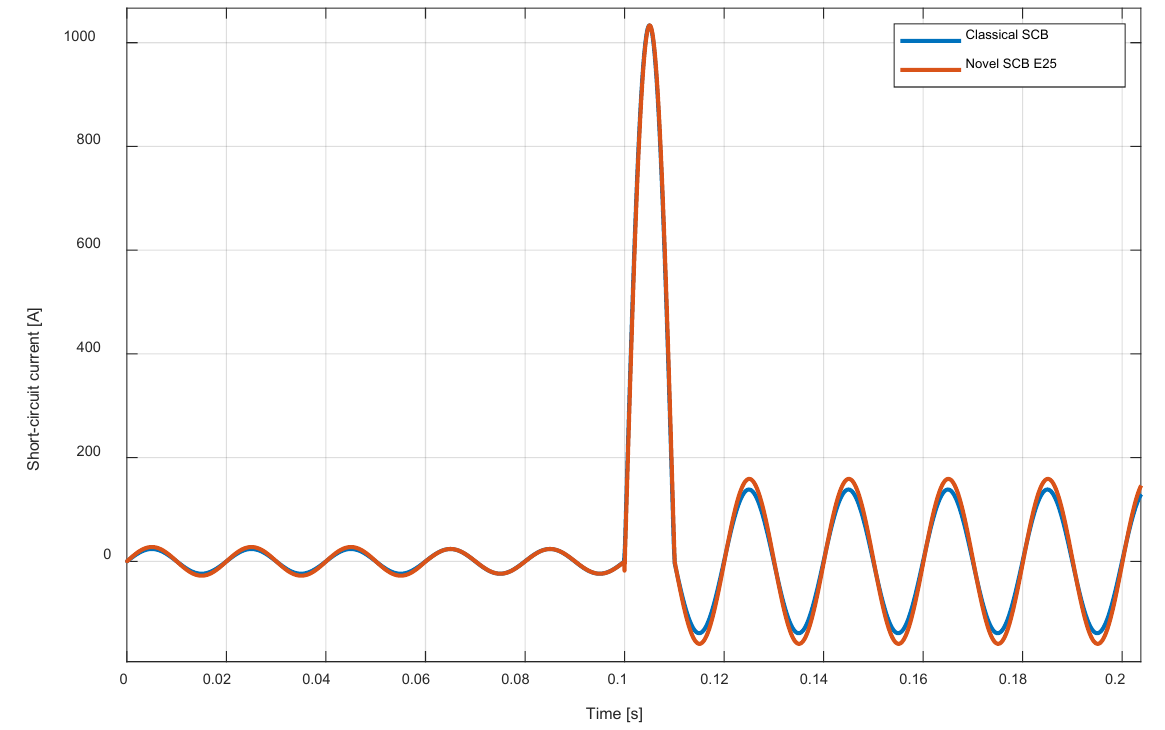
Figure 8. The comparison of the short-circuit current waveforms for novel and typical SCB. The test were made for loop impedance set as 0.125 Ω and voltage RMS value 200 V.